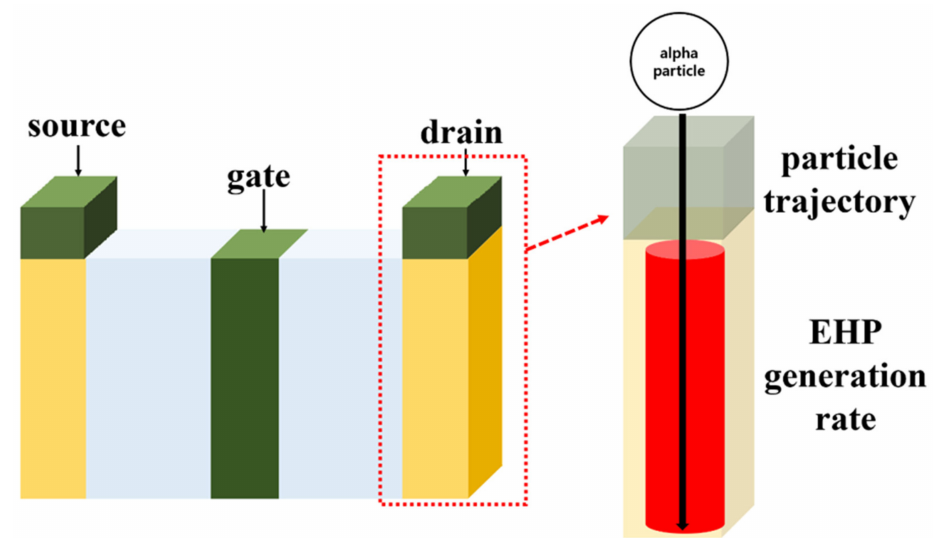
Figure 2. Schematic of the particle striking the drain: TCAD simulation shows how particles cause SEU in devices. SEU: single-event upset, TCAD: technology computer-aided design